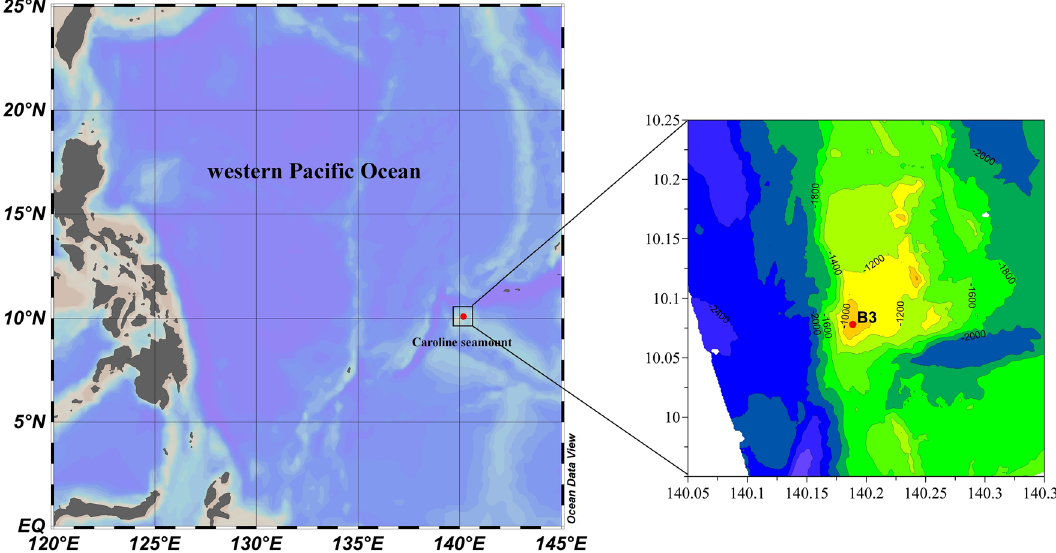
Figure 8. Sampling station B3 in the Caroline Seamount of the western tropical Pacific Ocean on June 2 to 3,